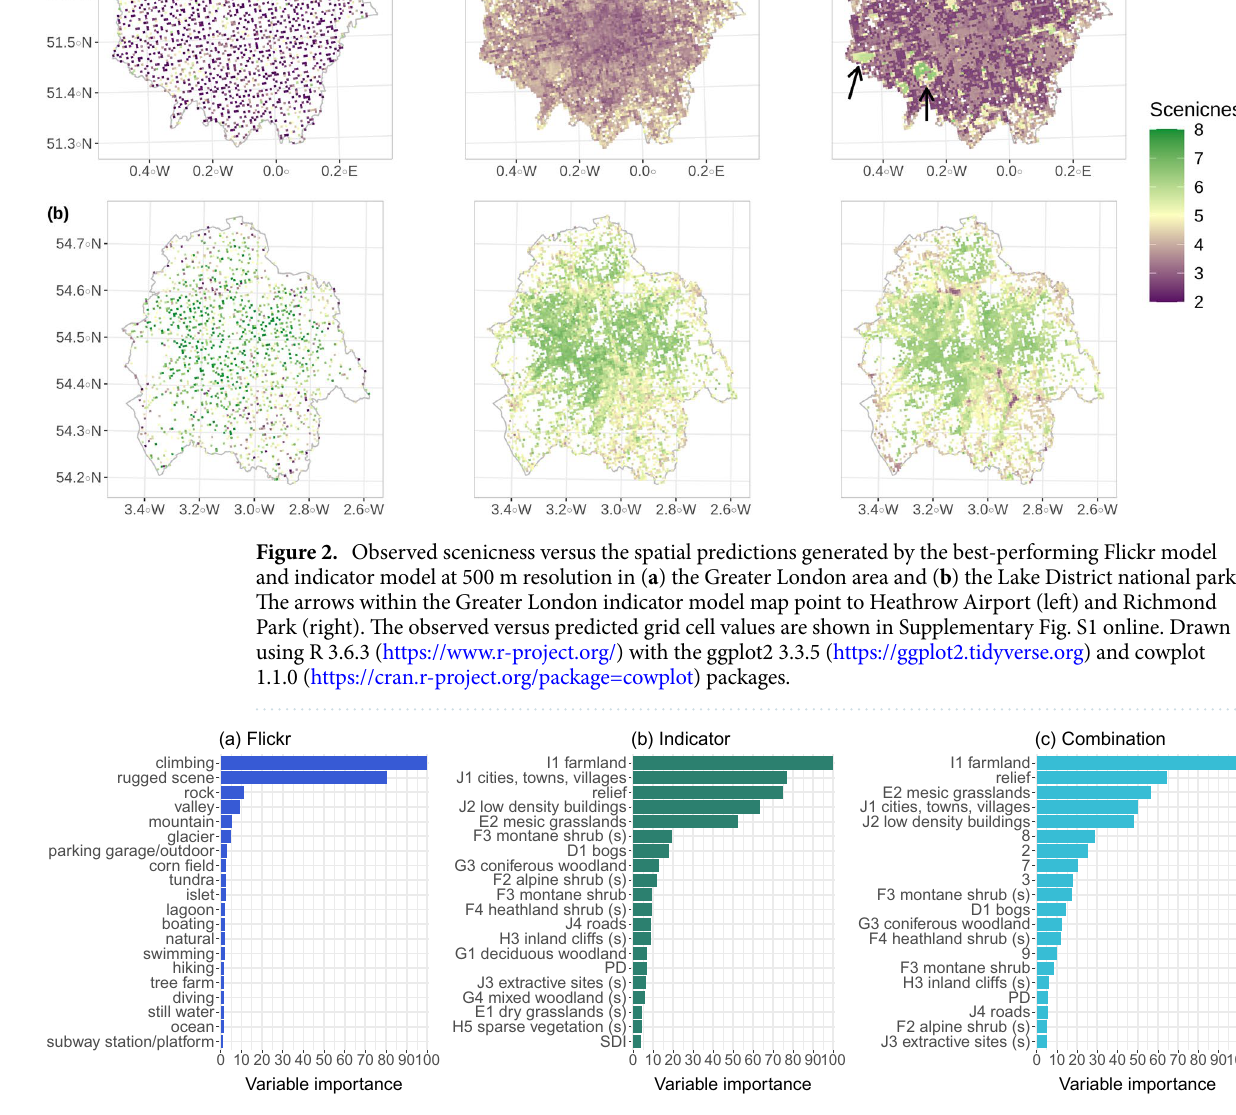
Figure 3. Most important variables for ( a ) the best-performing Flickr model, ( b ) environmental indicator model, and ( c ) best-performing combination model at 5 km resolution. “(s)” denotes an ecosystem in surrounding area variable. Supplementary Table S3 online contains a full list of ecosystem type codes and class descriptions. Drawn using R 3.6.3 (https:// www.r- proje ct. org/) and the ggplot2 3.3.5 (https:// ggplo t2. tidyv erse. org)